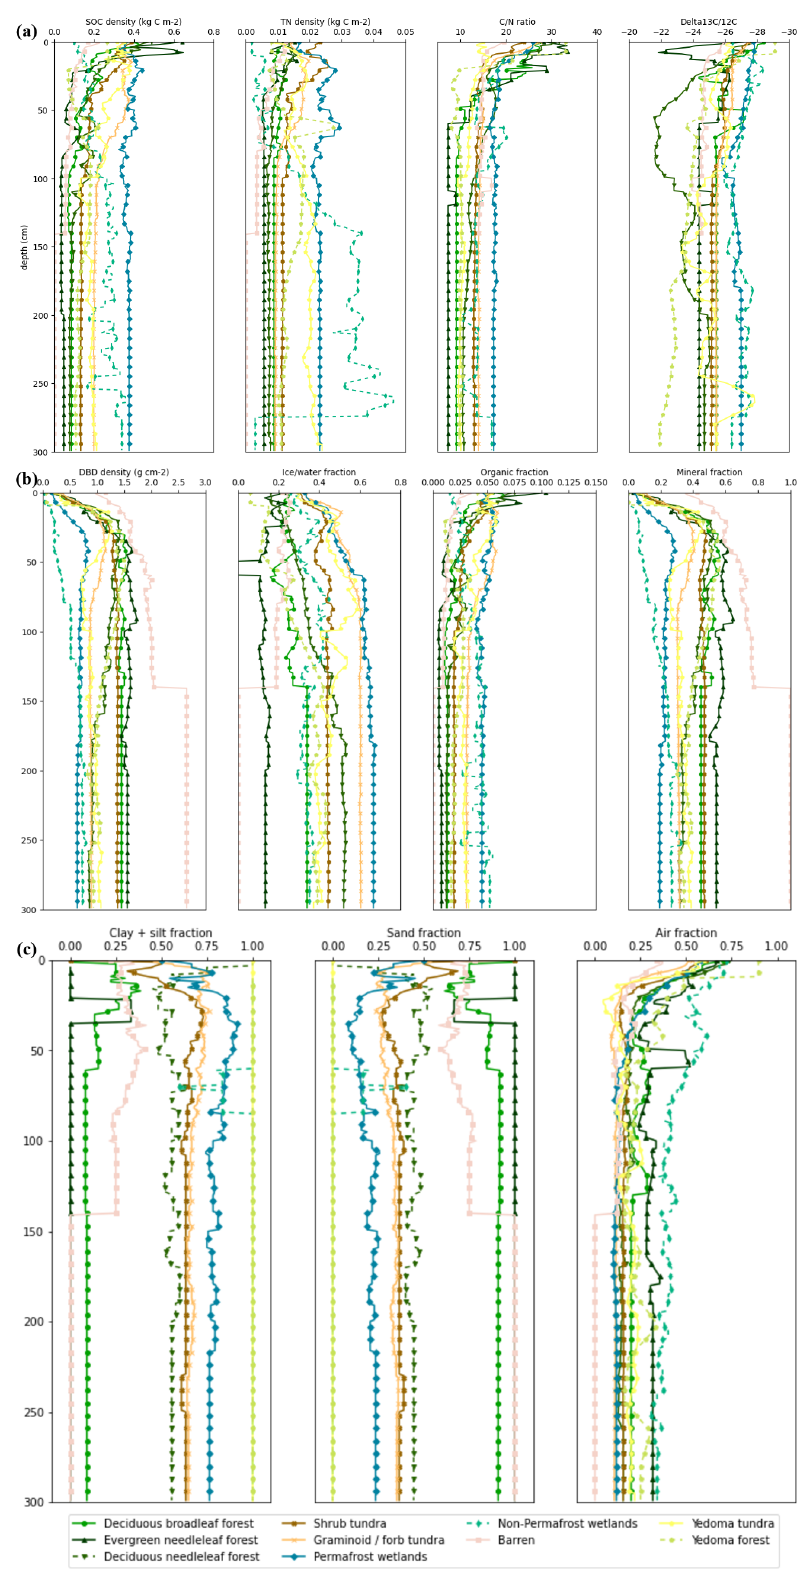
Figure 5. Typical vertical soil stratigraphies for all the land cover classes to 300cm depth separated for SOC density, TN density, C / N ratio, and delta 13 C/ 12 C (a) ; DBD density, ice/water fraction, organic fraction, and mineral fraction (b) ; and clay + silt fraction, sand fraction, and air fraction (c)